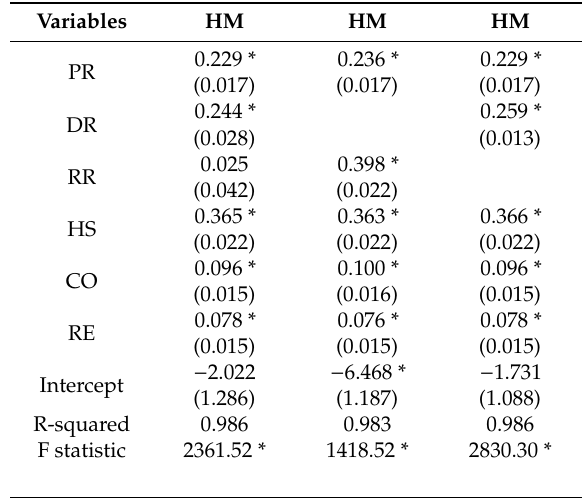
Table 6. Numerical score of HM regressed on six category numerical score